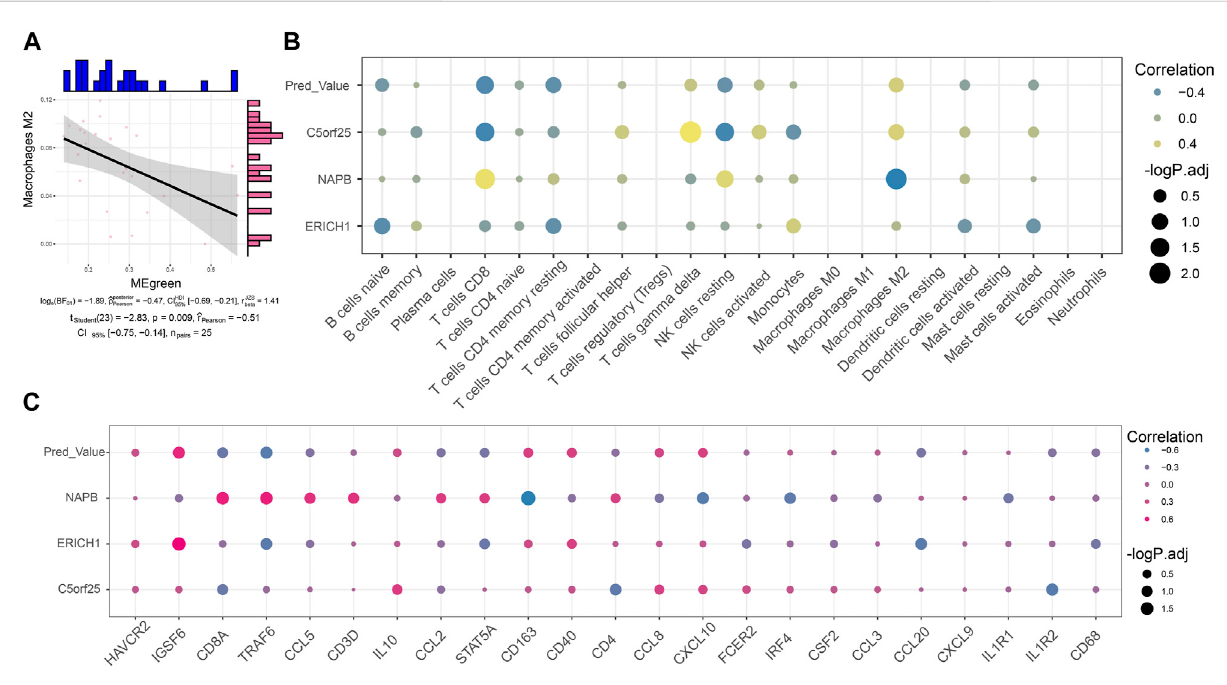
FIGURE 5 Co-expression modules reprogram the immune microenvironment of myasthenia gravis. (A) Series of correlation scatter plots showing expression correlation of immune cell in fi ltration abundance with diagnostic potency of MG dysregulated gene co-expression module scores. (B) Bubble plots showing correlation of MG dysregulated gene co-expression module-based Lasso model genes with immune cell in fi ltration abundance. (C) Bubble plots showing correlation of MG dysregulated gene co-expression module-based Lasso model genes correlated with immune checkpoint- associated genes and tertiary lymphoid structural marker